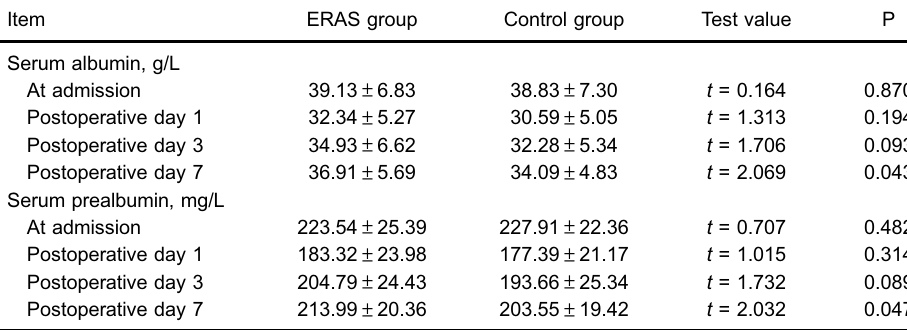
Table 5. Comparison of nutritional indicators between the two groups.